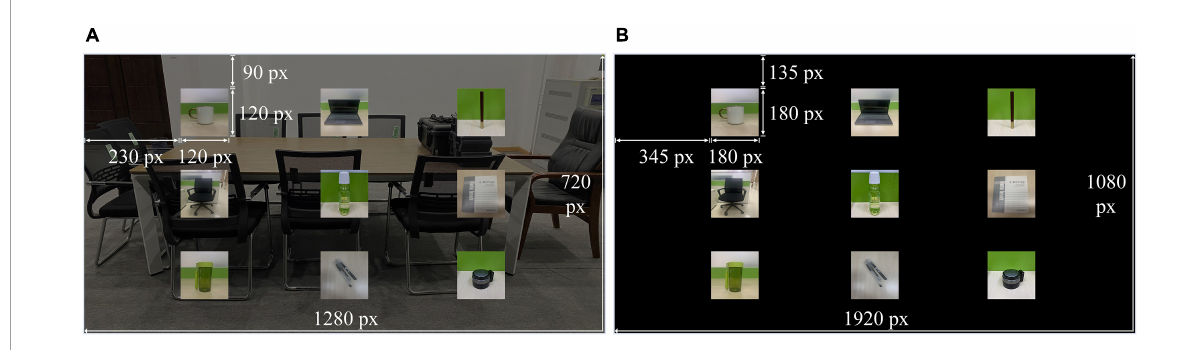
FIGURE3 Distribution of P300 stimuli in panels (A) AR–P300 and (B) CS–P300.